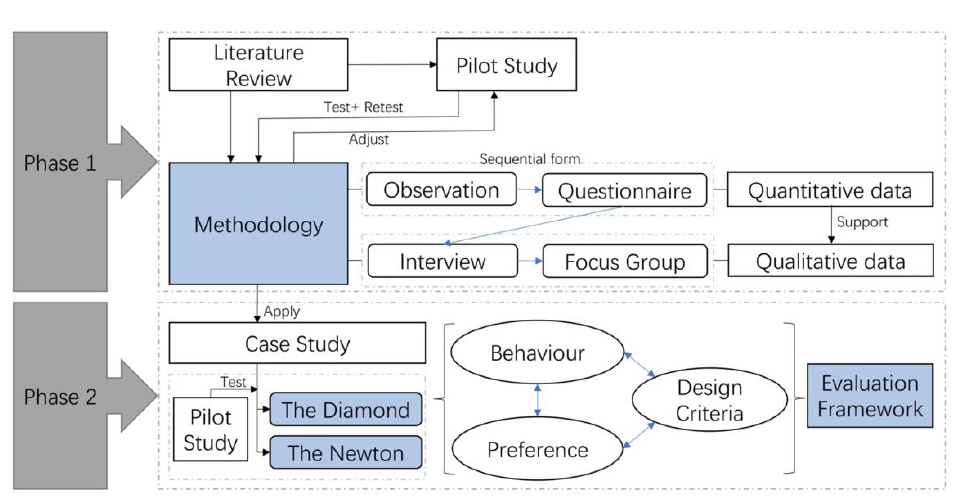
Figure 1. Research Design.